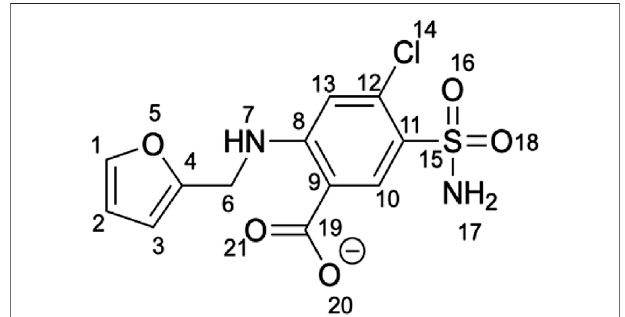
Frontiers in Cell and Developmental Biology |